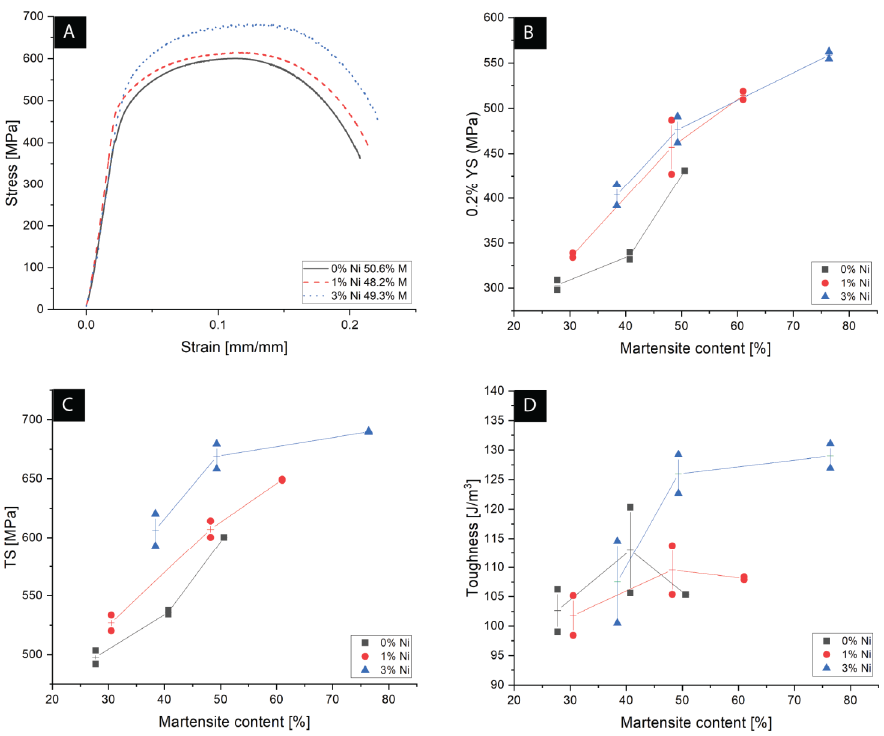
Figure 8. Representative engineering tensile stress–strain curves for martensite content around 50 per cent with 0, 1, and 3-wt% Ni ( A ). Variation of 0.2% YS ( B ), TS ( C ), and toughness ( D ), as a function of the martensite and nickel content.